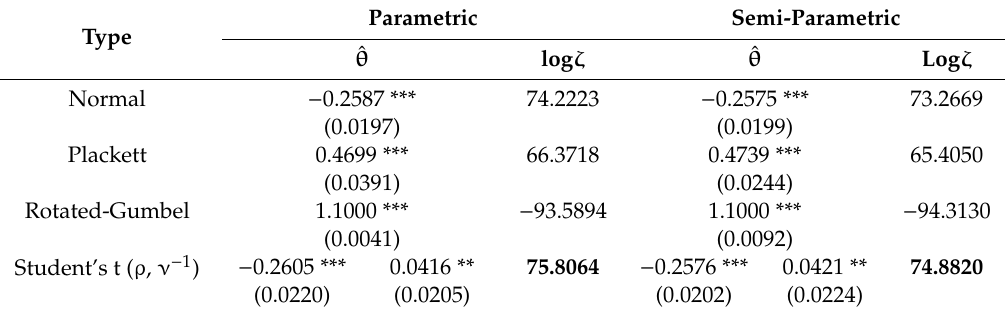
Table 10. Constant copula parameter estimation (South African